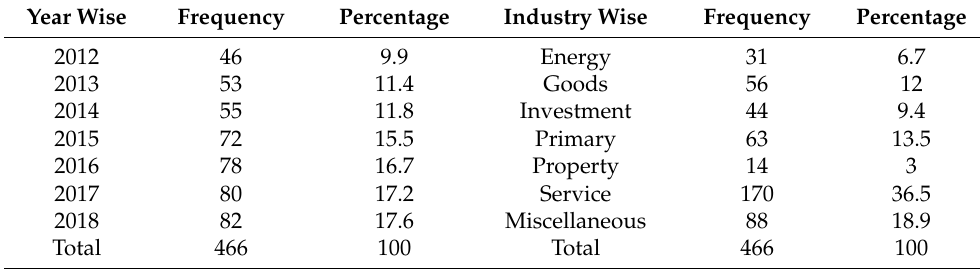
Table 1. Distribution of sample